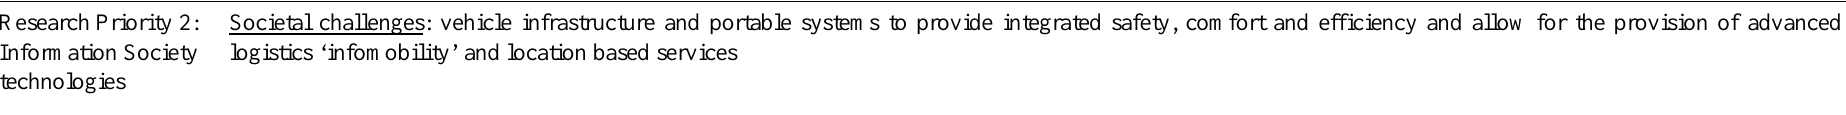
Table 1. Opportunities for transport RTD activities in